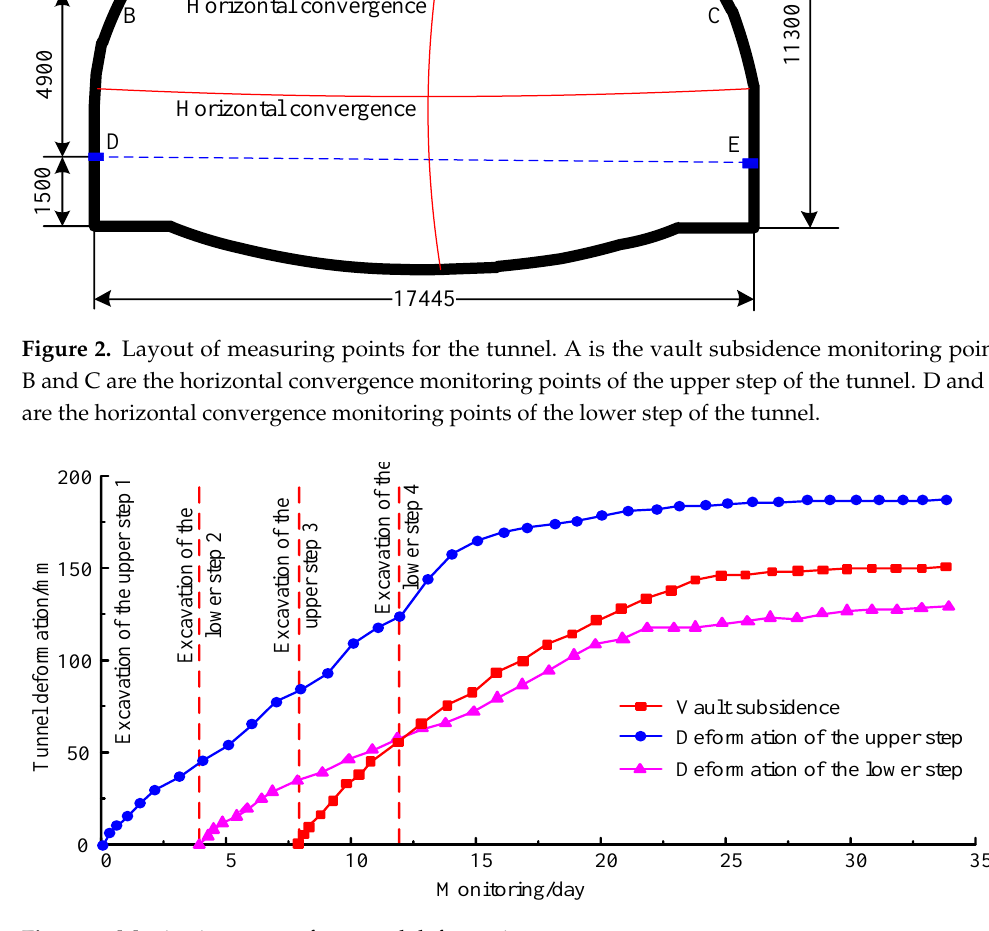
Figure 3. Monitoring curves for tunnel